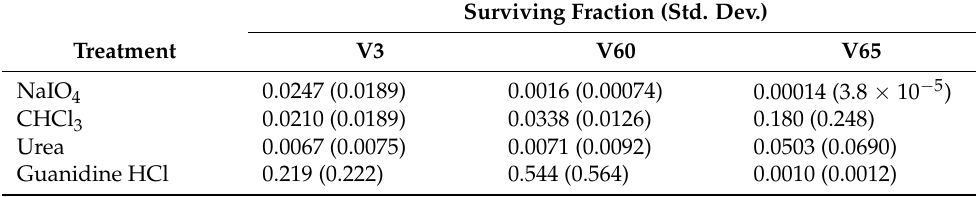
Table 2. Virion inactivation by